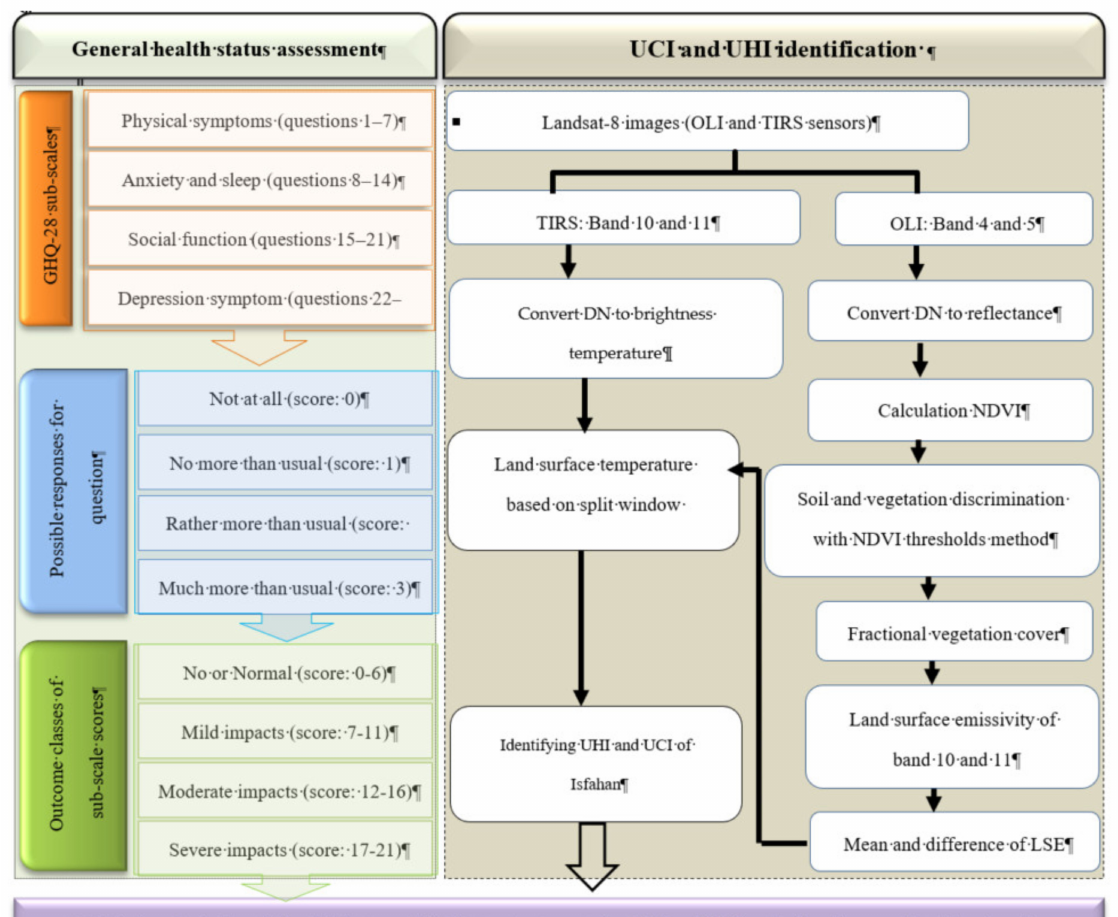
Figure 2. The main flowchart of the study (general health questionnaire-28 (GHQ-28) methodology and retrieving land surface temperature